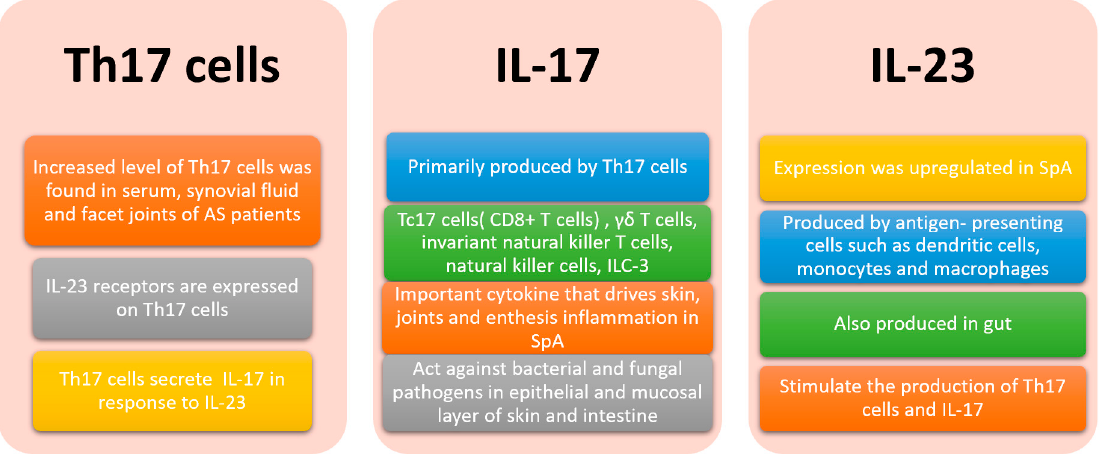
Figure 2. The role of IL17/IL23 axis in spondyloarthritis (SpA).